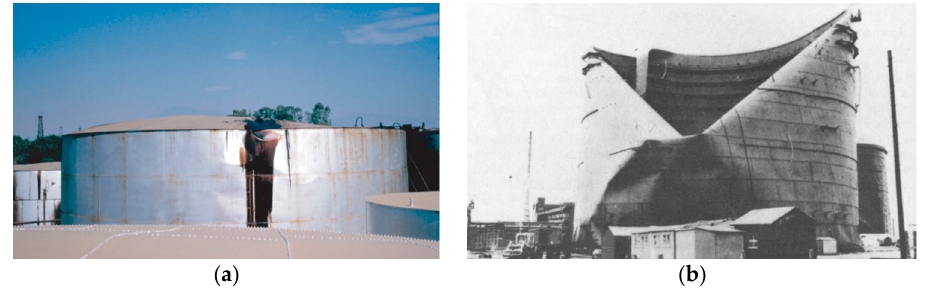
Figure 1. Failure cases of liquid storage tank. ( a ) Earthquake. ( b ) Wind [1].